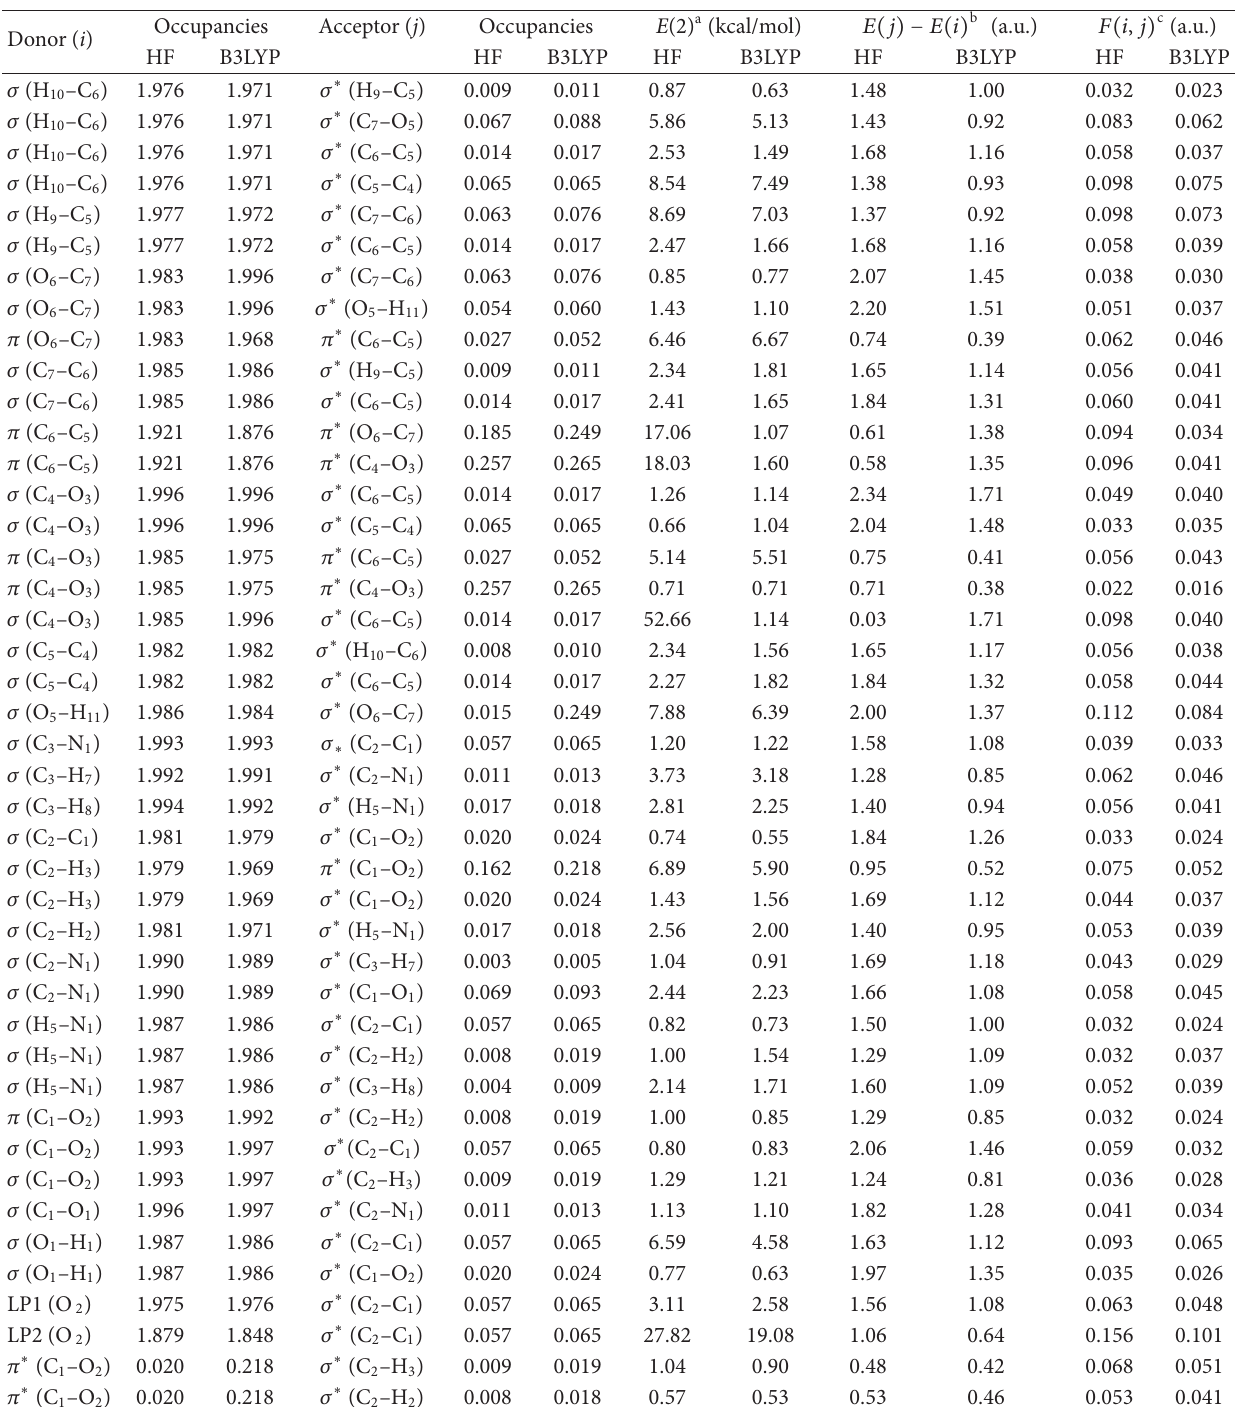
T 4: (a) Second-order perturbation theory analysis of Fock matrix on NBO basis for sarcosine-maleic acid by using the HF and B3LYP methods with 6-31++G(d,p) basis set. (b) Second-order perturbation theory analysis of Fock matrix on NBO basis for sarcosine-maleic acid by using the HF and B3LYP methods with 6-31G(d,p) basis